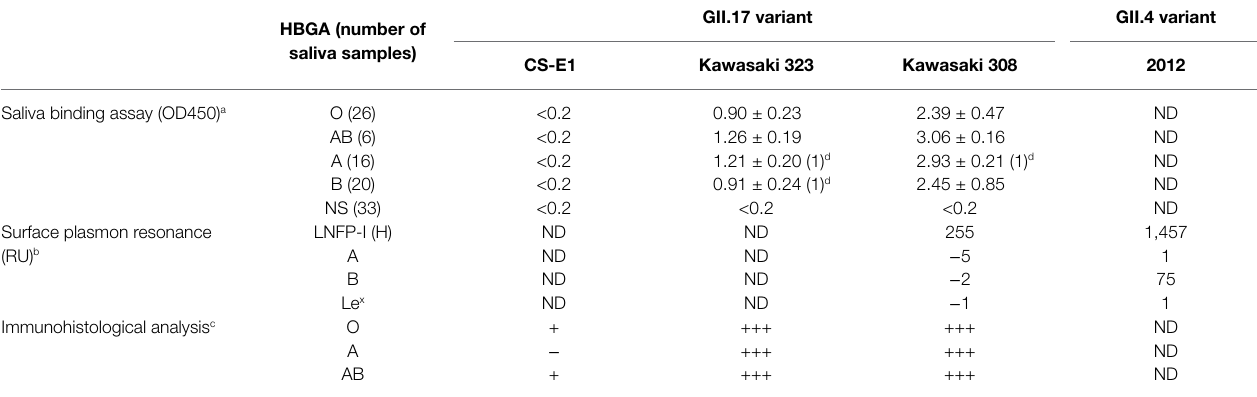
TABLE 1 | GII.17 interactions with HBGAs.